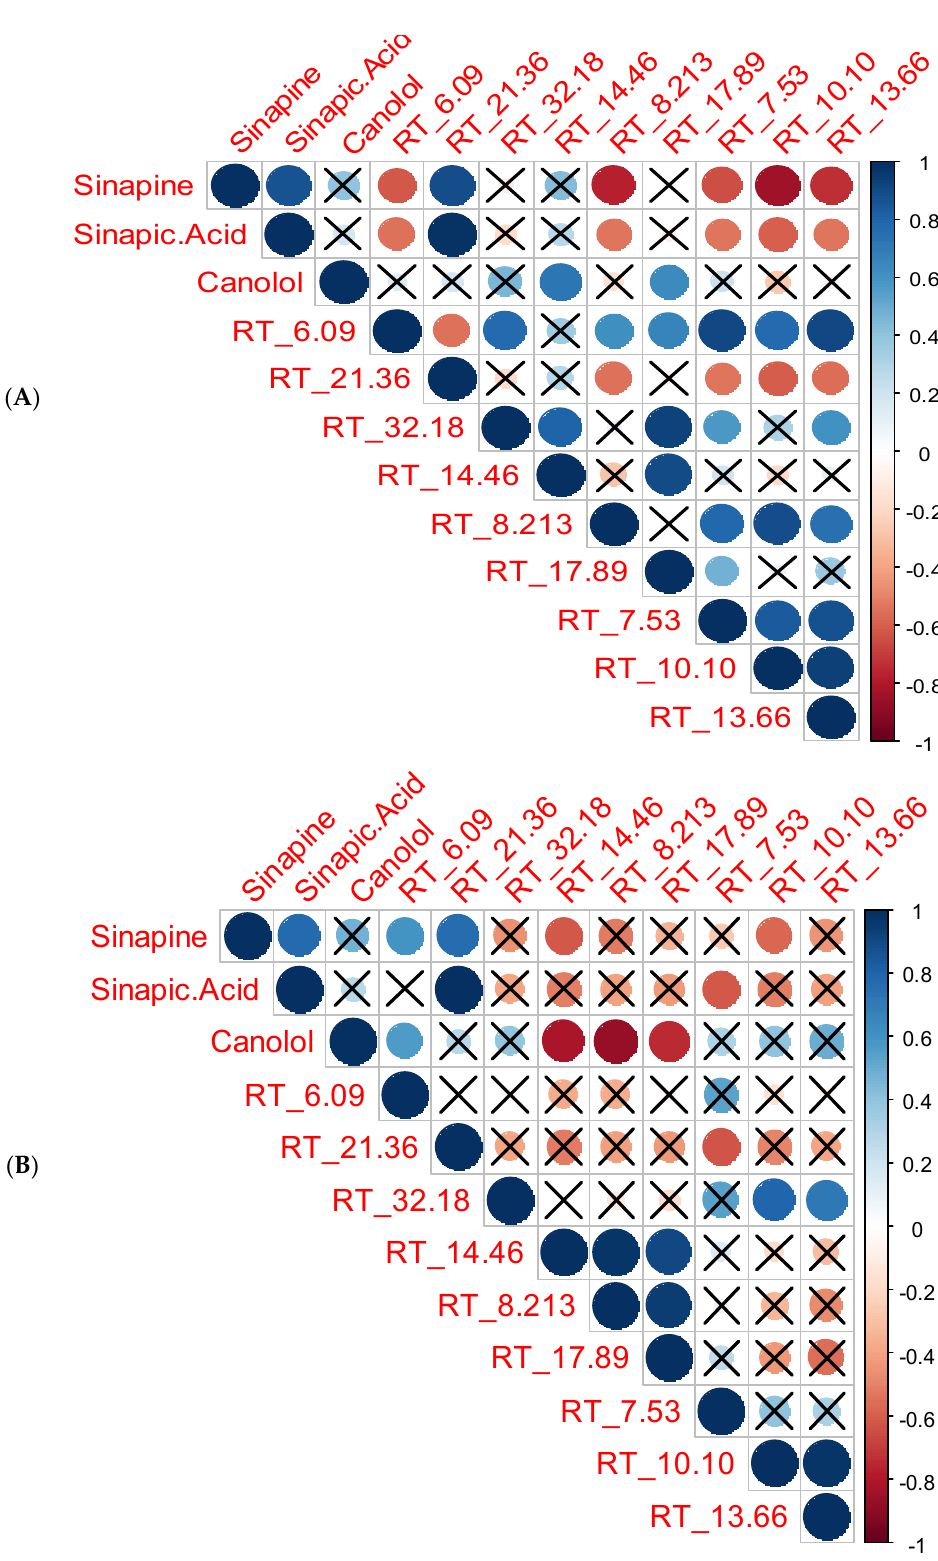
Figure 3. Correlation plot for the phenolic compounds (( A )—methanol, ( B )—ethanol).